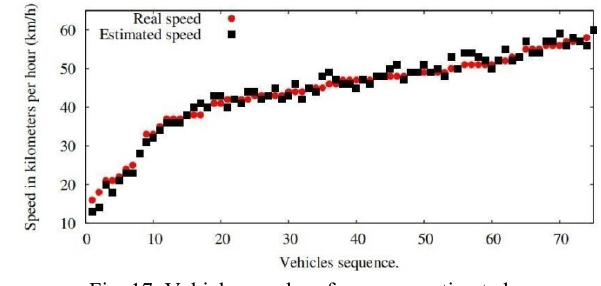
Fig. 17: Vehicle speed performance: estimated speed and the real